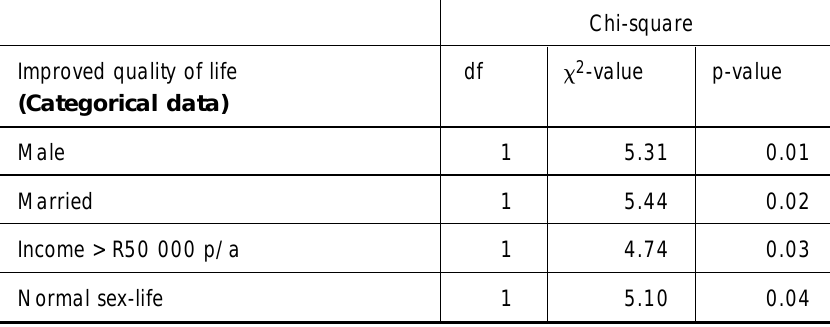
Table 1V: On admission into the